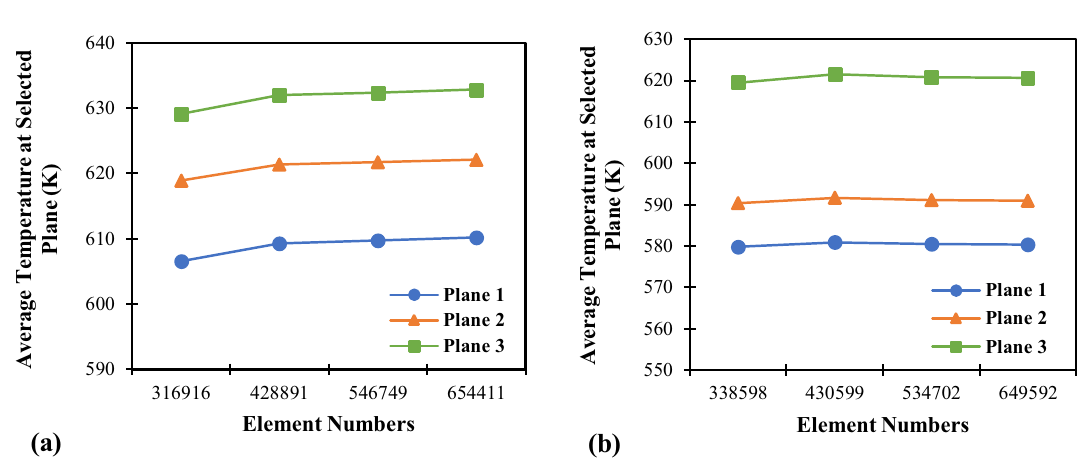
Figure 2. Average bed temperature at selected location for the hydrogen absorption process in the metal hydride reactor under various grid numbers. ( a ) Average temperature at selection location for case 1, and ( b ) average temperature at selected location for case